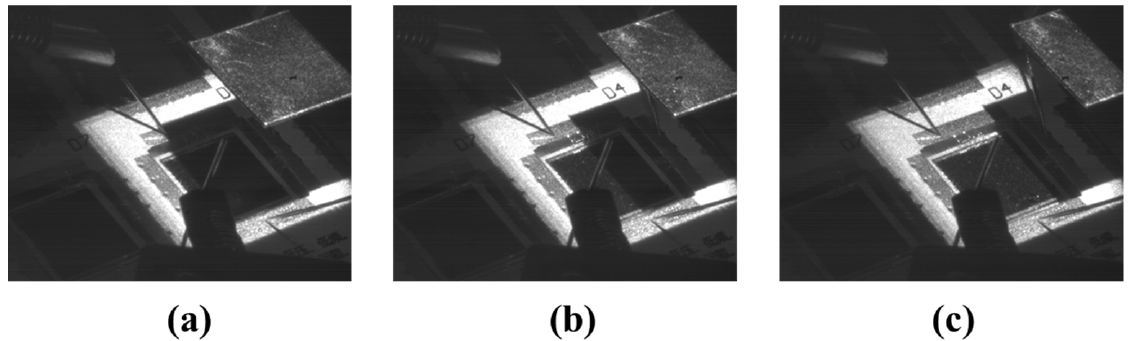
Figure 2. Light spot intensity distribution after homogenization.